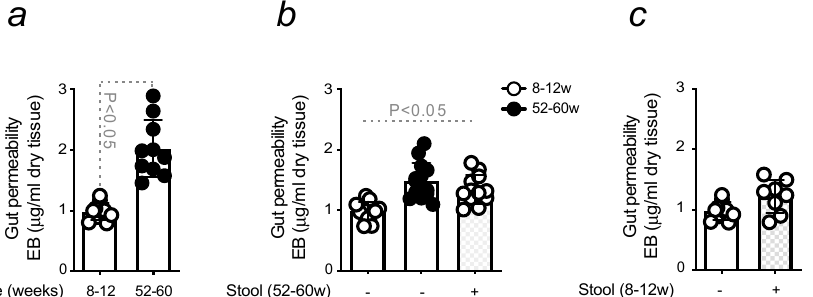
Figure 2. Age-related dysbiosis compromises gut integrity. ( a ) Gut permeability was measured by Evans Blue (EB) extravasation in conventional young or old mice. The effect of fecal microbiota transplantation is shown ( b ) in young GF mice colonized with conventional old stool or ( c ) with young samples. The results are expressed as mean ± SD ( n = 7–10 mice per group). Statistical analysis was performed by applying the student’s t-test or one-way ANOVA.